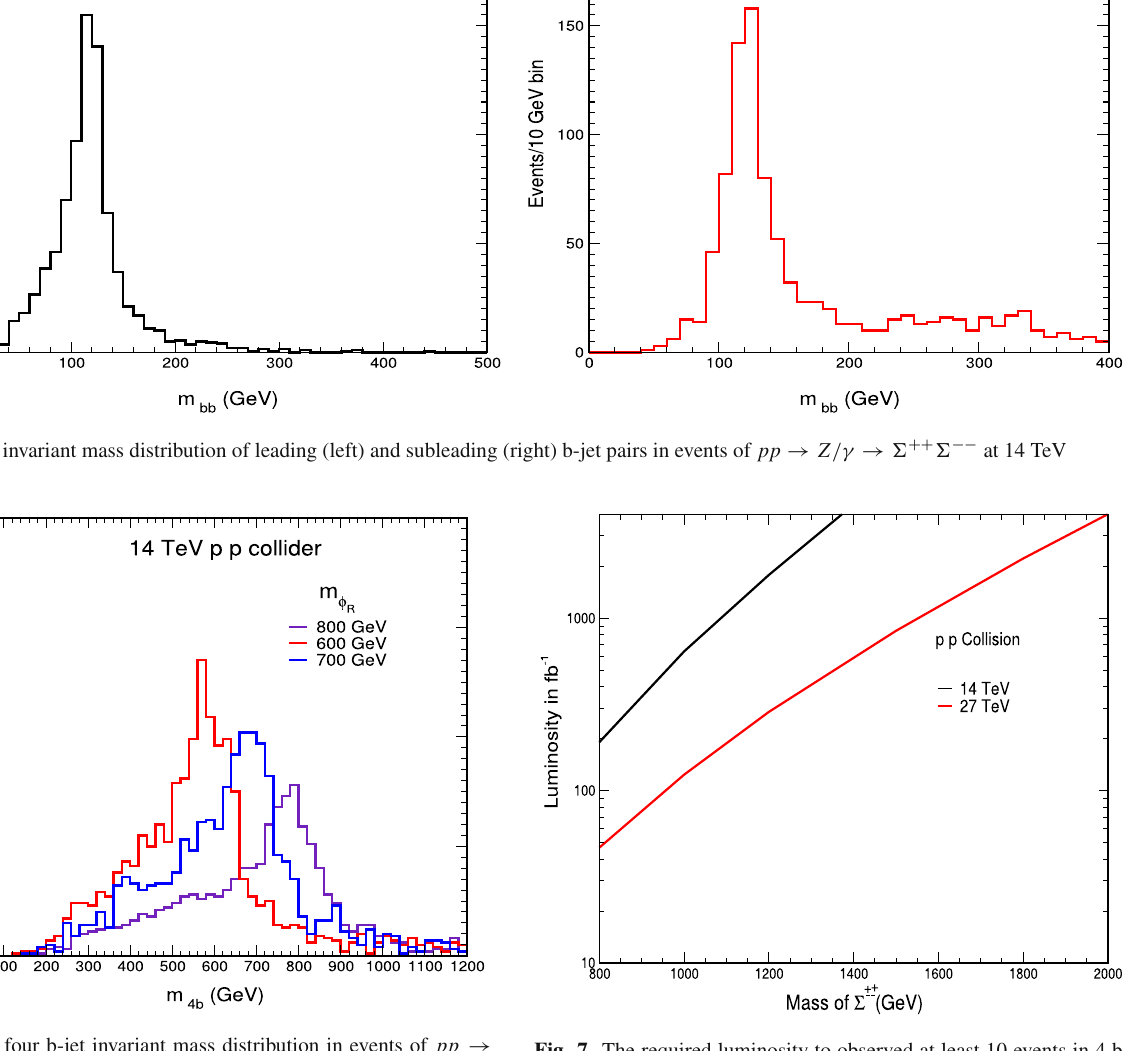
Fig. 7 The required luminosity to observed at least 10 events in 4 b- jets and at least one lepton final state for pp → Z /γ → (cid:4) ++ (cid:4) −− at 14 TeV and 27 TeV as a function of (cid:4) ±± mass